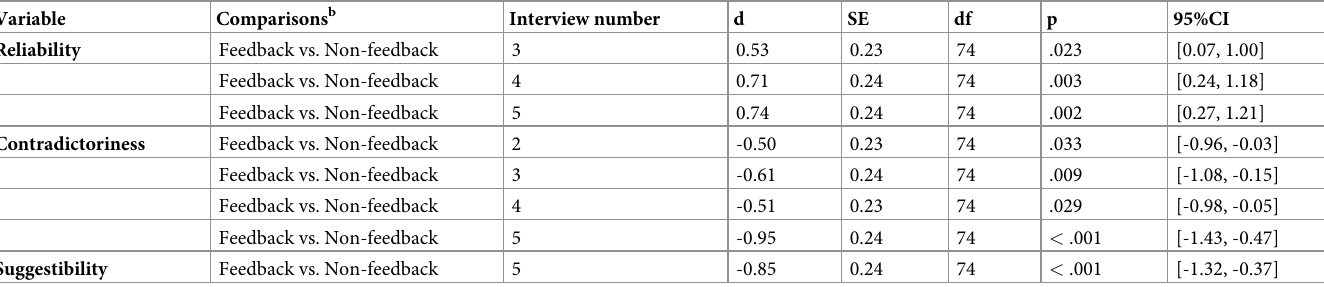
Table 7. a The individual effect of the HT or feedback intervention on the assessment of information from avatars over time. Variable